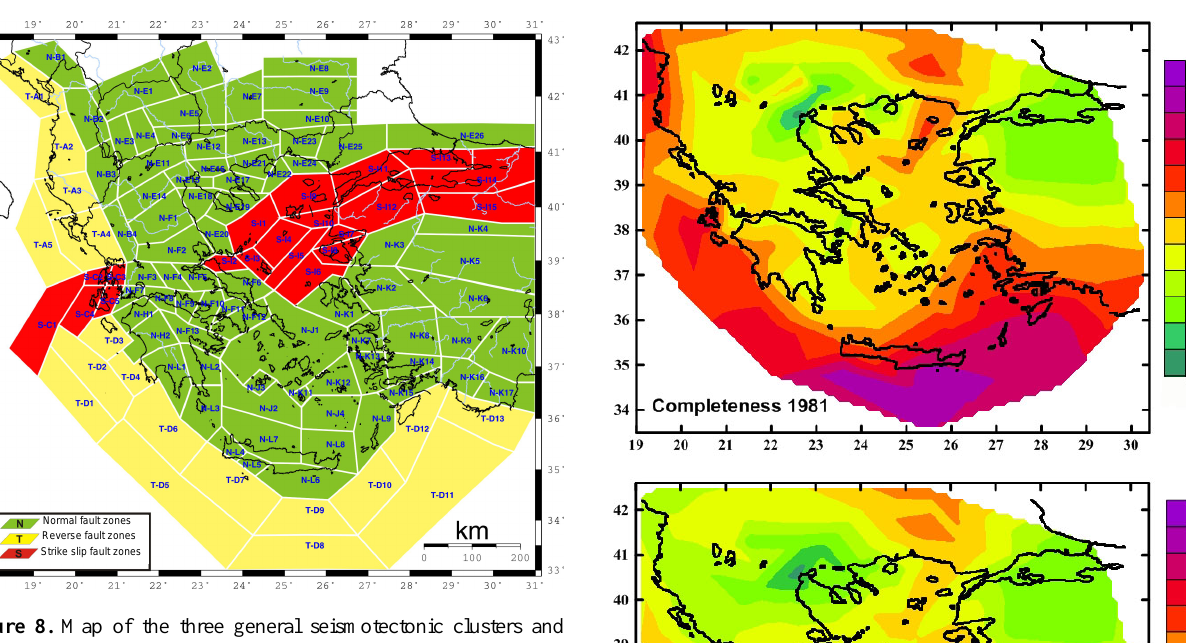
Figure 8. Map of the three general seismotectonic clusters and the 11 groups in which the 113 new shallow seismic zones were grouped. The code names of the 113 new seismic zones defined in this work are also presented.